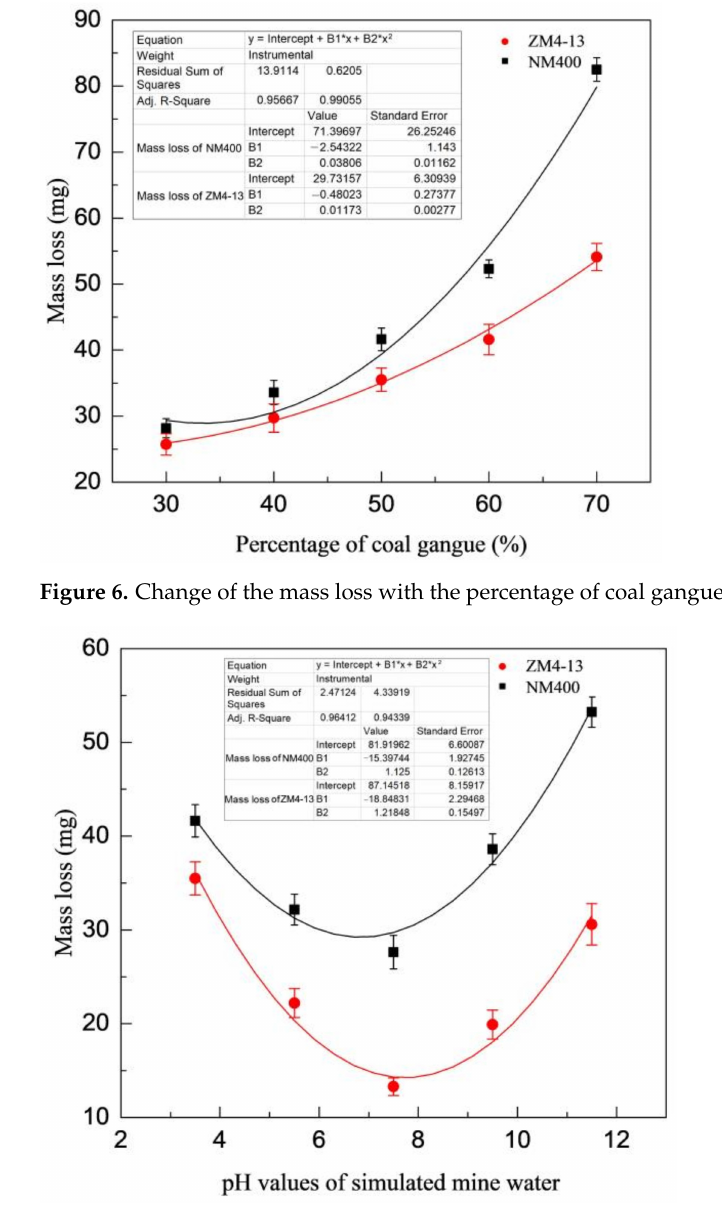
Figure 7. Change of the mass loss with pH value of simulation mine